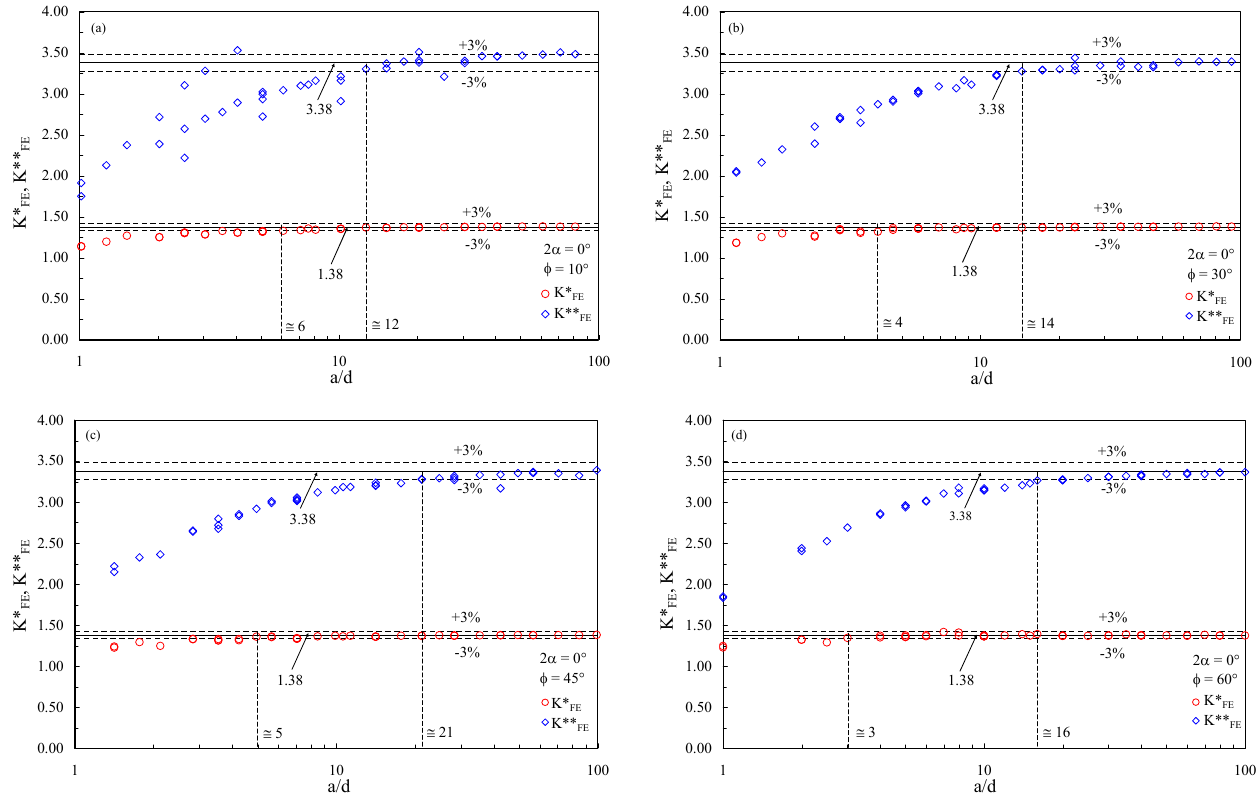
Figure 3: Calibration of the PSM approach for a crack (2 α = 0°) under mixed mode (I+II) loading: (a) ϕ = 10°; (b) ϕ = 30°; (c) ϕ = 45°; (d) ϕ = 60°. Non-dimensional SIFs related to mode I and mode